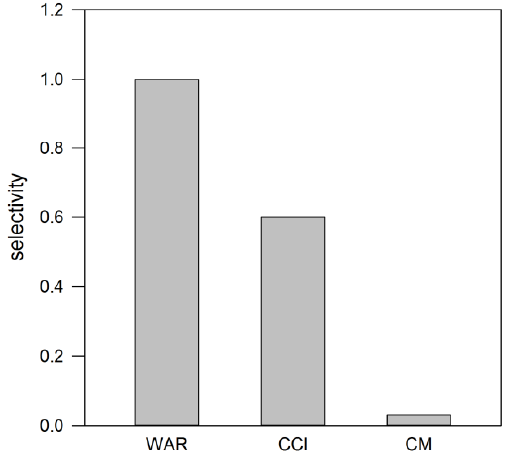
Figure 6. Selectivity (α) and change of Gibbs free energy (ΔΔG) of WAR-imprinted capillary measured towards coumarin (CM) and coumachlor (CCl) by using 50% v / v acetonitrile added to 5 mmol∙L −1 phosphate buffer, pH 6.4.